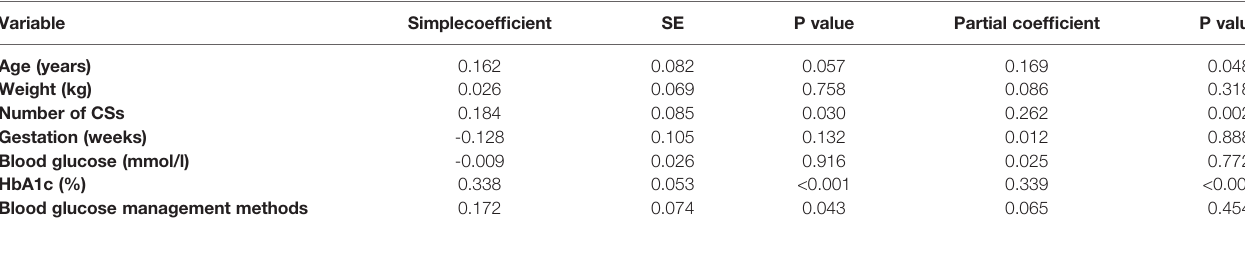
TABLE 3 | Correlation analysis to examine factors affecting postoperative sufentanyl requirements variable.